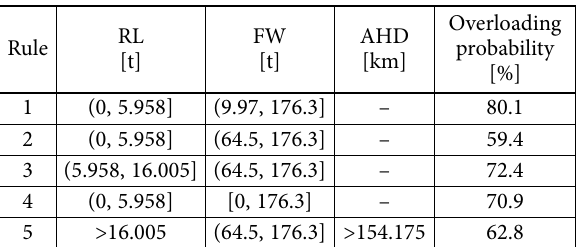
Table 5. Interaction rules